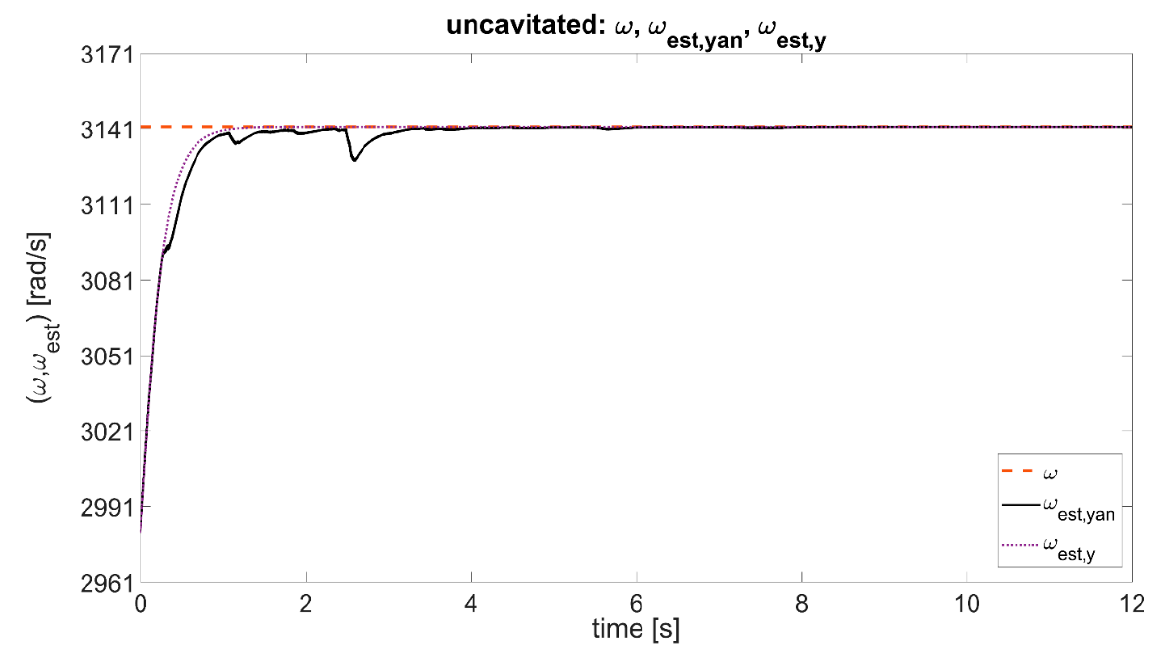
Figure 5. Frequency estimation performance in the case of uncavitated condition. In Figure 6 the frequency estimation performance in time, considering the analytical output noise y an , is compared in uncavitated and cavitated conditions.